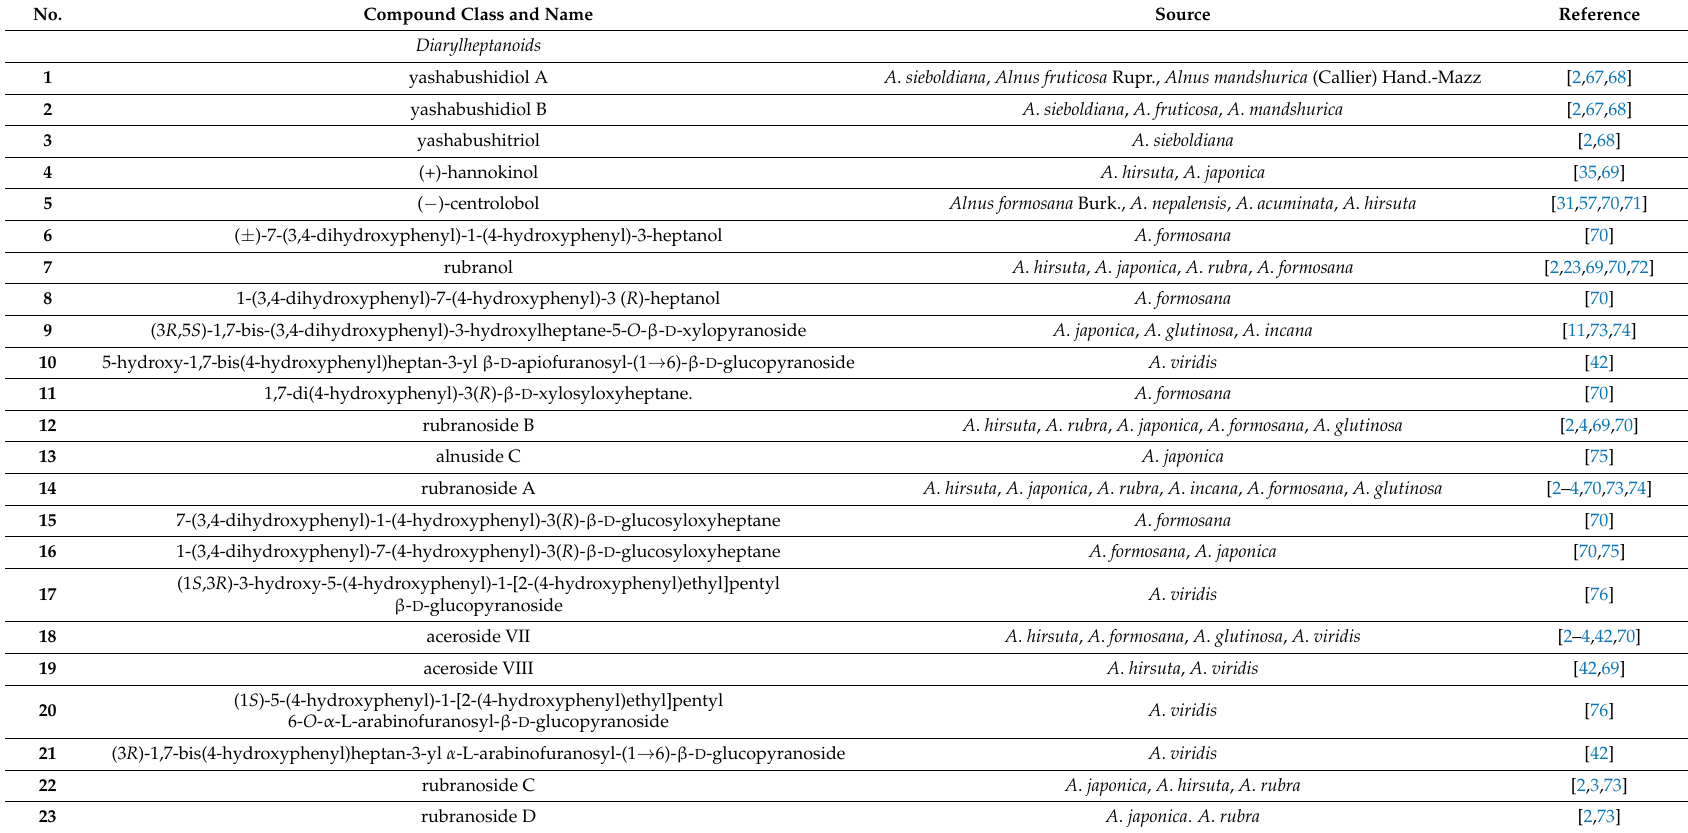
Table 17. Chemical Constituents from the Genus Alnus